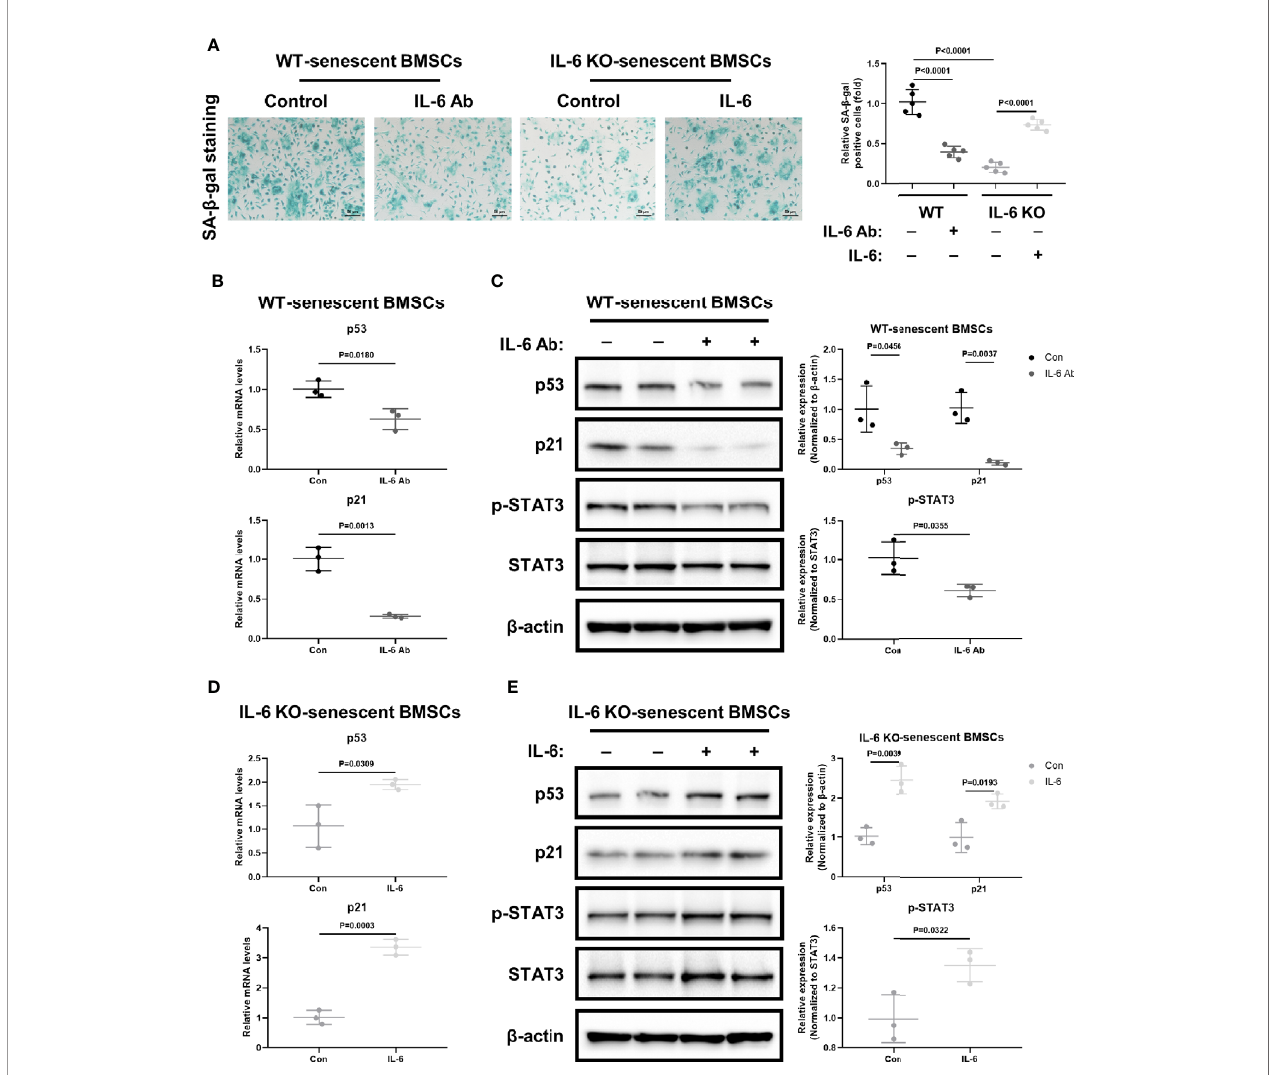
FIGURE 6 | IL-6 accelerated senescence of BMSCs through IL-6/STAT3 pathway. (A) Representative images for SA- b -Gal staining of replicative BMSCs with or without IL-6 neutralization antibody from WT mice, and with or without recombinant mouse IL-6 treatment from IL-6 KO mice. (Cell nucleus: dark blue, SA- b -gal- positive cell: cyan, scale bar = 50 m m). Quanti fi cation of SA- b -Gal positive cells evaluated with Image J software (right panel). (B) The mRNA levels of p53 and p21 in replicative BMSCs with or without IL-6 antibody treatment from WT mice. (C) Western blot analysis of indicated proteins (p53, p21, p-STAT3, STAT3, b -actin) in replicative BMSCs with or without IL-6 antibody treatment from WT mice. The expression of p53 and p21 was normalized against b -actin, and the expression of p- STAT3 was normalized against STAT3. Quantitative analysis with Image J software was shown on the right panel. (D) The mRNA levels of p53 and p21 in replicative BMSCs with or without IL-6 treatment from IL-6 KO mice. (E) Western blot analysis of indicated proteins in replicative BMSCs with or without recombinant IL-6 treatment from IL-6 KO mice. The expression of p53 and p21 was normalized against b -actin, and the expression of p-STAT3 was normalized against STAT3. Quantitative analysis with Image J software was shown on the lower panel. Data were expressed as mean ±